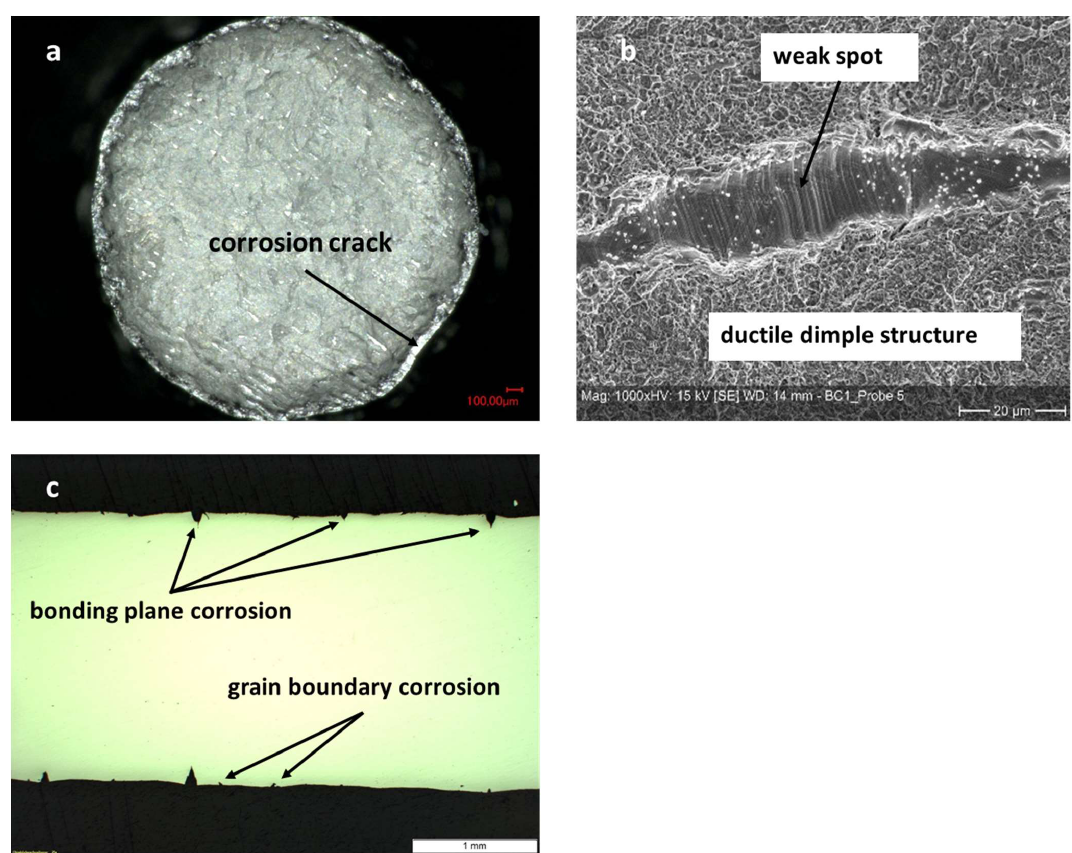
Figure 14. Micrographs of tensile tested diffusion bonded and aged (1000 h at 100 °C in 70% sulfuric acid) samples made of Hastelloy BC-1. ( a ): Overview of fracture surface displaying corrosion attack depth. ( b ): Detailed view of the fracture surface showing non-bonded area and slip bands as well as dimples. ( c ): Longitudinal cut along center of failed sample. Pronounced corrosion at bonding planes and some intergranular corrosion can be seen.